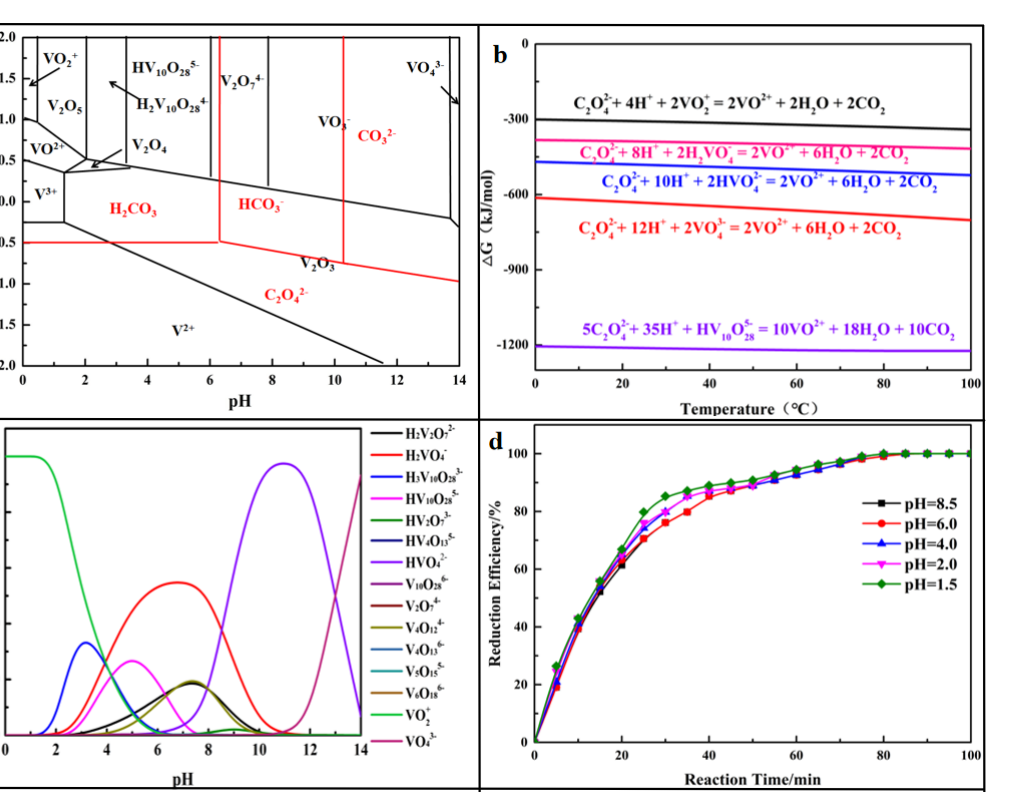
Figure 1. ( a ) E-pH diagram of vanadium (V) and oxalic acid at 30 °C; ( b ) relationship of Δ G-T; ( c ) The V-species in V-H 2 O system at 30 °C (0.05 M); ( d ) effect of pH on the reduction efficiency of vanadium (V) at 30 °C and n(O)/n(V) =